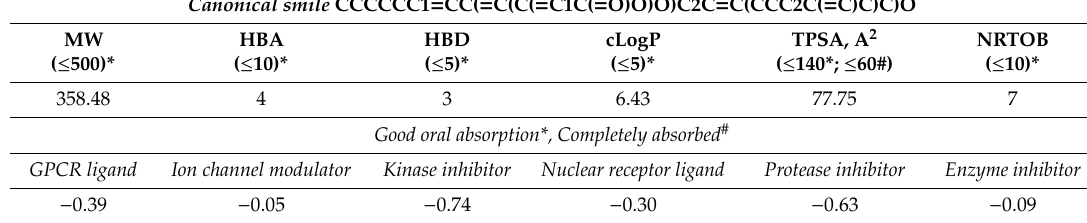
Table 1. Computed physicochemical properties and bioactivity scores of cannabidiolic acid (CBDA). HBD, hydrogen bond donor; HBA, hydrogen bond acceptor; cLogP, partition coe ffi cient; TPSA, topological polar surface area; NRTOB, number of rotatable bonds; GPCR, G protein-coupled